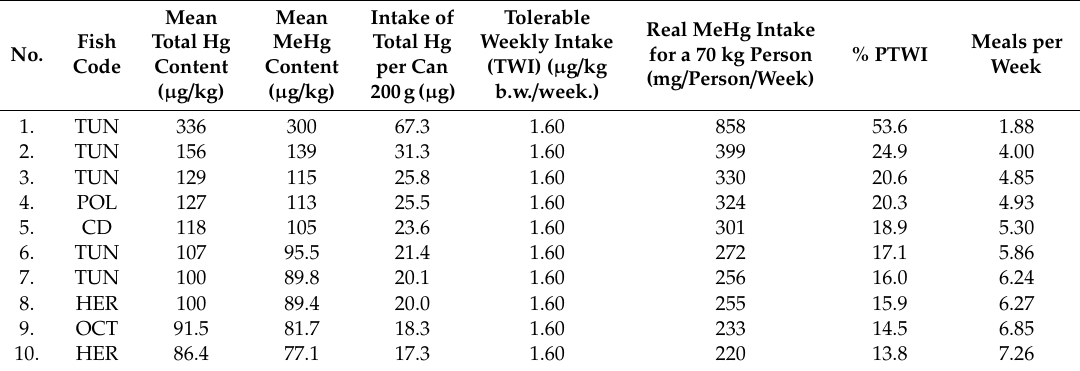
Table 5. Summary of TWI values for products with the highest mean mercury content (TUN-tuna, POL-pollock, CD-cod, HER-herring,